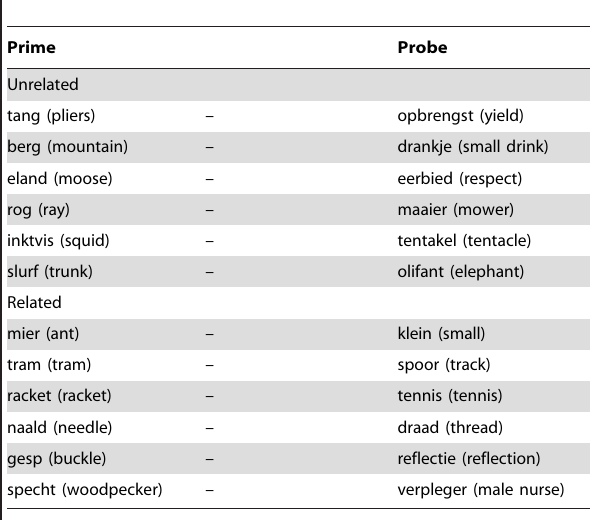
Table 2. Examples of stimuli used in the experiment.